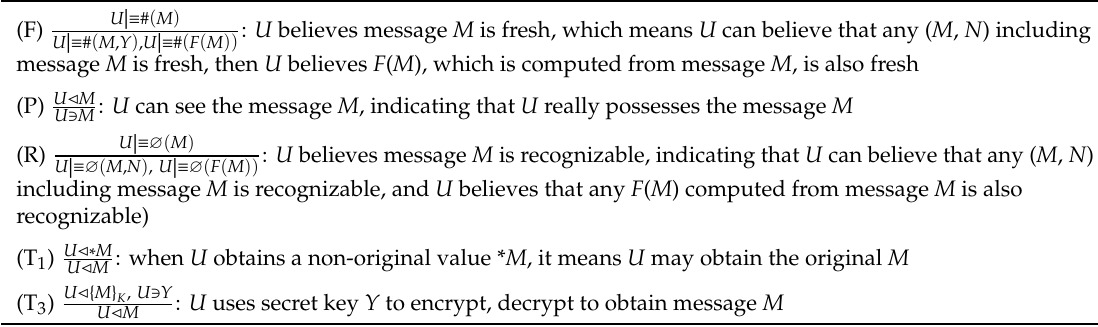
Table 3. The logical rules of the proposed